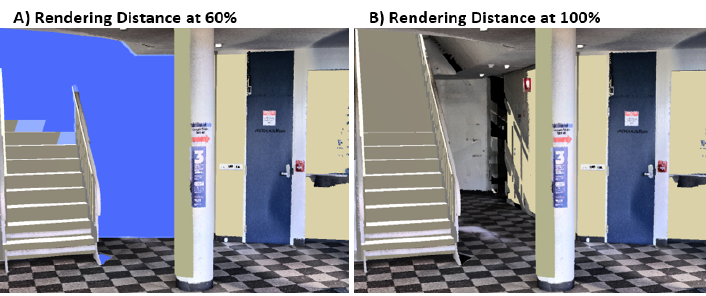
Figure 6. This figure demonstrates the rendering-distance visualisation, which mitigates the amount of elements visible by controlling the camera-rendering